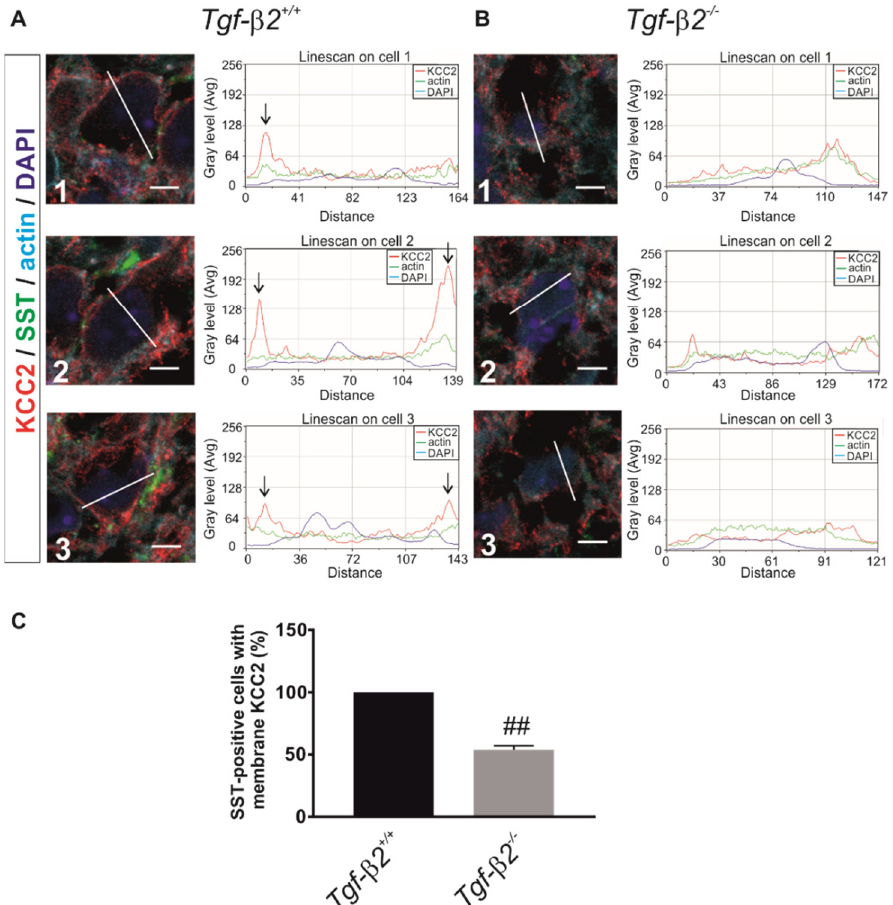
Figure 6. Membrane KCC2 in neurons of the pre-Bötzinger complex is reduced in Tgf- β 2 − / − mice. Fixed brainstem cryosections from Tgf- β 2 +/+ ( A ) and Tgf- β 2 − / − ( B ) embryos at E18.5 immunolabeled with antibodies against KCC2 (red), somatostatin (SST; green) and phalloidin (actin; turquoise). Nuclei were labeled with DAPI (deep blue). KCC2 distribution profile as visualized by line scans for KCC2 (red line), actin (green line) and DAPI (blue line) immunofluorescence for 3 randomly selected neurons in Tgf- β 2 +/+ (A1–A3) and Tgf- β 2 − / − (B1–B3). Scale bars: 5 µ m. ( C ) The number of SST-positive neurons showing KCC2 immunofluorescence at the plasma membrane in Tgf- β 2 +/+ and Tgf- β 2 − / − mutants by analysis of approximately 600 neurons. Counted SST-positive preBötC neurons with membrane KCC2 in Tgf- β 2 +/+ was set to 100%. ## p < 0.01 for significant decrease in Tgf- β 2 − / − compared to Tgf- β 2 +/+ (two-tailed unpaired Student’s t test with Welch’s correction, n = 3 animals per